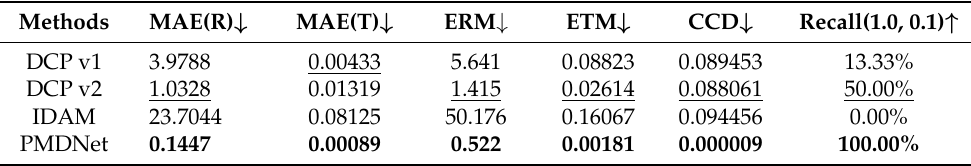
Table 8. Results on clean density-uniform BIM scenarios. Bold and underline denote best and second best performance,